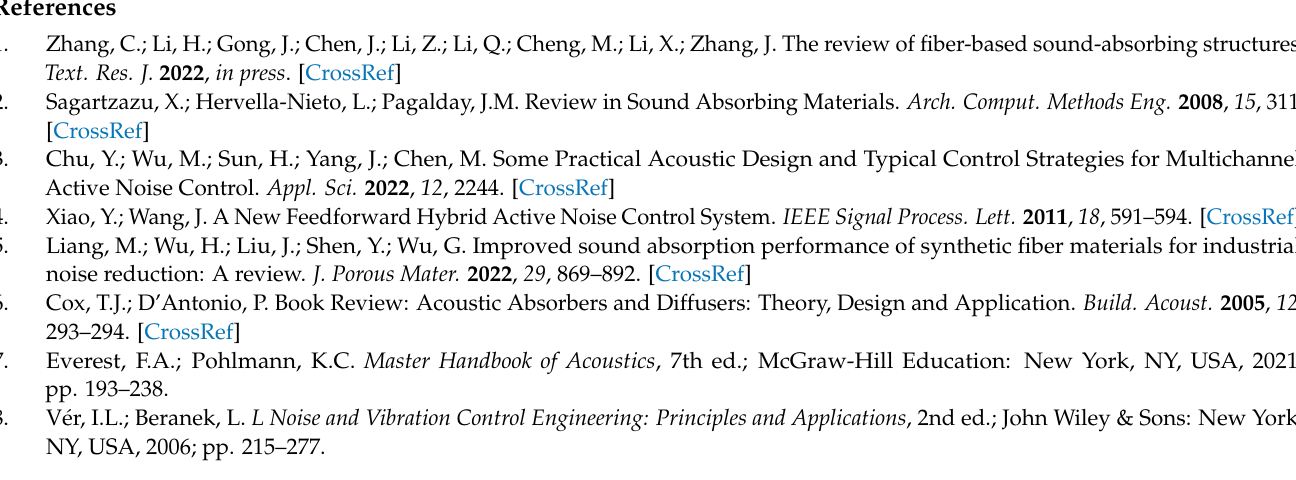
setup. Figure S2: FESEM micrographs of PE foam samples before (a,c) and after (b,d) corona poling at 55 kV for 3 min; Figure S3: Stiffness of PE foam samples with and without corona poling before (a) and after (b) annealing at 80 ◦ C for 1 h; Figure S4: Tan delta of PE foam samples with and without corona poling before (a) and after (b) annealing at 80 ◦ C for 1 h; Figure S5: Dielectric constant of PE foam samples with and without corona poling before (a) and after (b) annealing at 80 ◦ C for 1